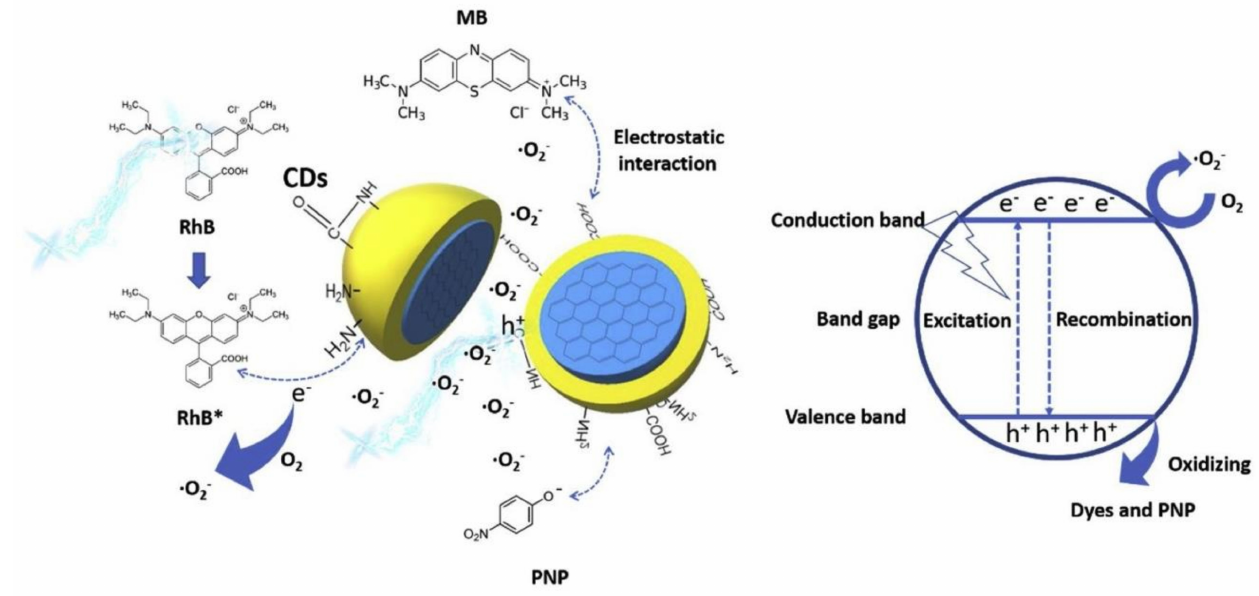
Figure 14. Schematic representation of the interaction between CQDs and dyes during photocatalytic degradation. Reprinted from ref. [114], with permission from